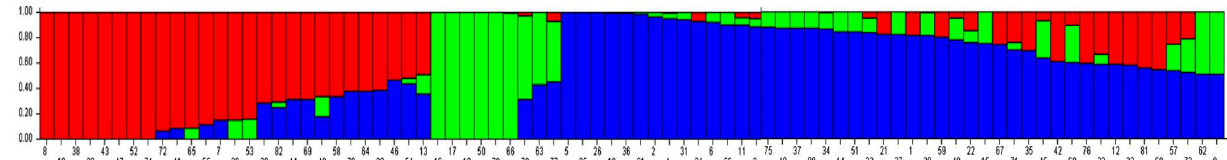
Figure 1. Estimated population structure of 82 wheat accessions ( K = 3) using STRU CTU RE. Three subpopulations were revealed, C1—red color, C2—green color and C3—blue color. The accession number corresponds to the serial number mentioned in Supplementary Table